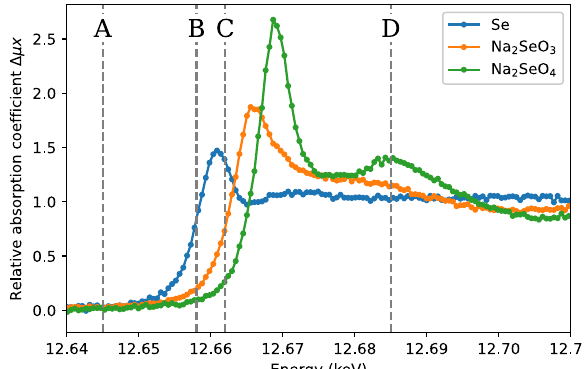
Figure 3. Background-subtracted and normalized K-edge absorption spectra of elemental Se, Na 2 SeO 3 [Se(IV)] and Na 2 SeO 4 [Se(VI)]. The vertical lines indicate the acquisition photon energies of 12.645 ( A ), 12.658 ( B ), 12.662 ( C ), and 12.685 ( D ) keV.